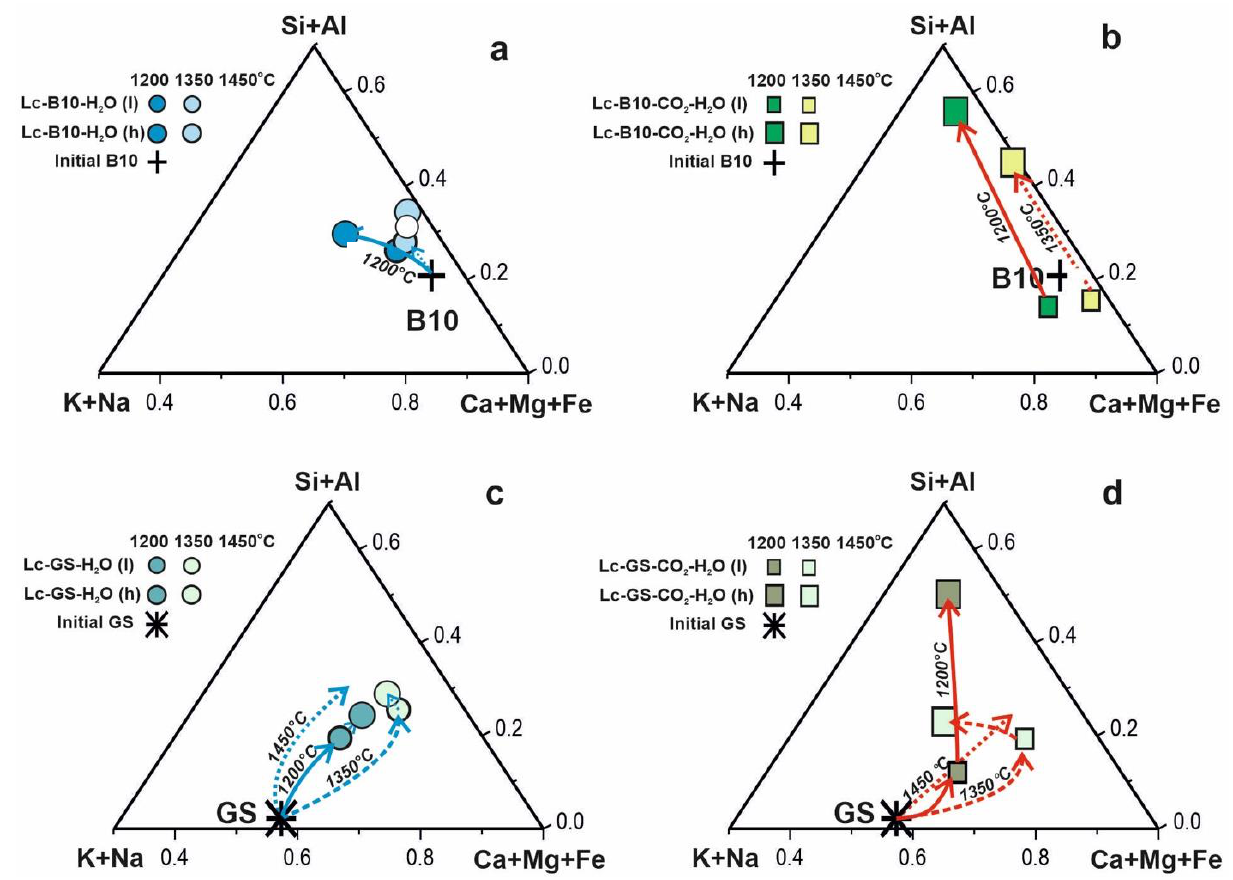
Figure 5. Ternary diagrams of Si + Al − Ca + Mg + Fe − Na + K (mol.%) for compositions of experimental melts and starting carbonatites B10 and GS. ( a ): Lc-B10-H 2 O system; ( b ): Lc-B10-CO 2 -H 2 O; ( c ): Lc-GS-H 2 O system; ( d ): Lc-GS-CO 2 -H 2 O system; l = low and h = high additive of molecular CO 2 and/or H 2 O.